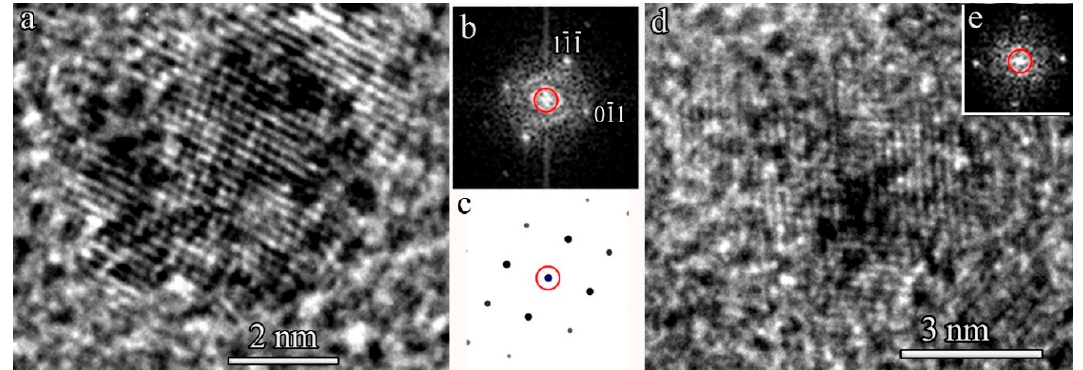
Figure 3. HRTEM images ( a , d ) and FFT patterns ( b , e ) of the Ru NPs in Ru-PPP ( a , b ) and Ru-PPP-S ( d , e ). Panel ( c ) shows a simulated electron diffraction pattern for hcp-Ru.